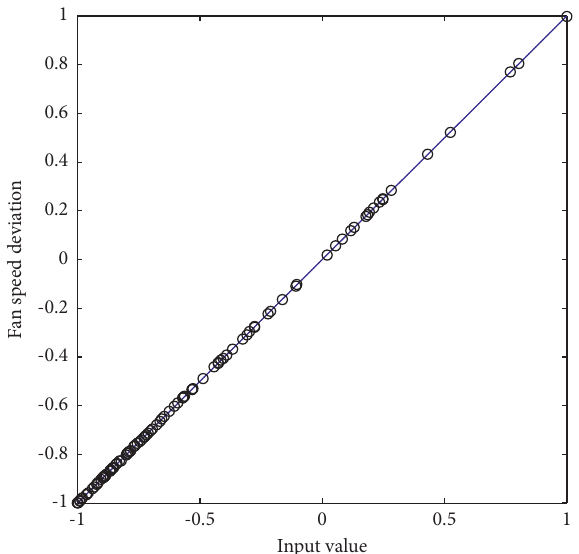
-1 Figure 8: Deviation threshold curve for abnormal changes in unit